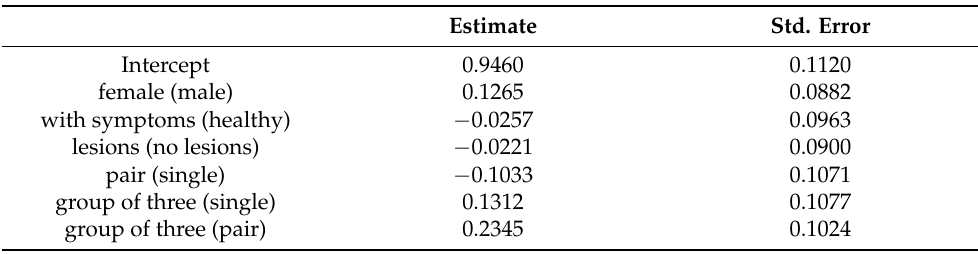
Table 5. Table of coefficients for the linear regression model with hair corticosterone concentration (HCC) of kits as dependent